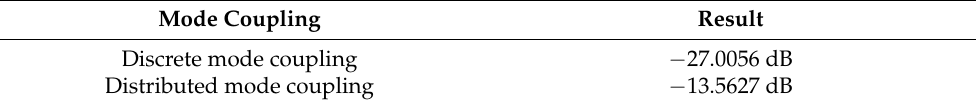
Table 1. The mode coupling test result of the TMF.